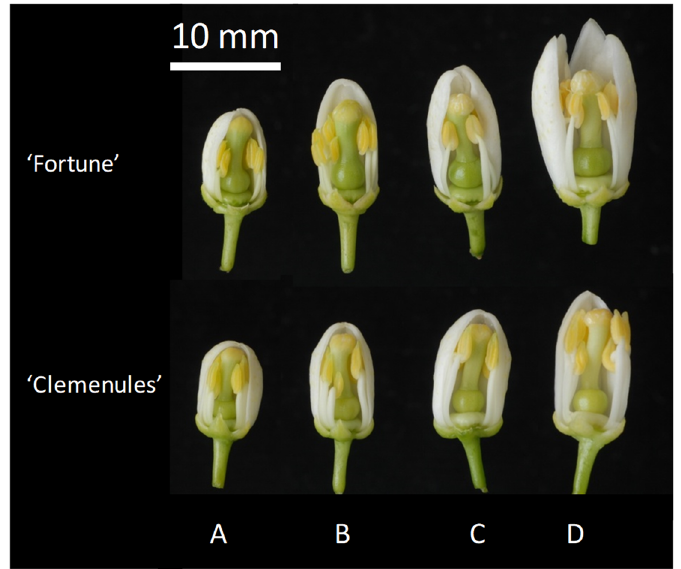
Figure 1. Developmental stages of the self-pollinated flowers used to evaluate SI breakdown by bud pollination in ‘Fortune’ mandarin and ‘Clemenules’ clementine.